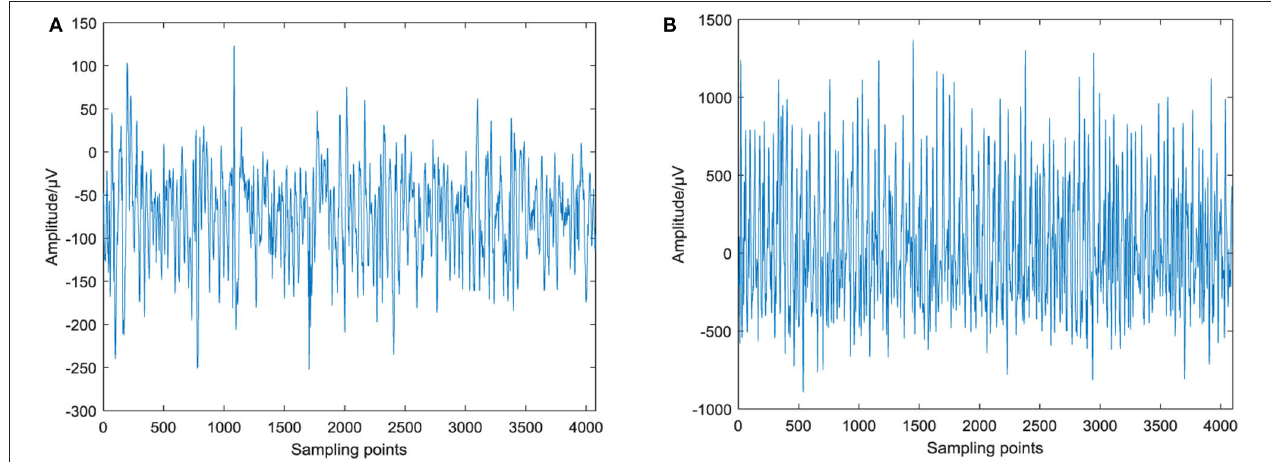
FIGURE 1 | Raw EEG signal of epilepsy. (A) EEG signal of interictal epilepsy and (B) EEG signal of ictal epilepsy.